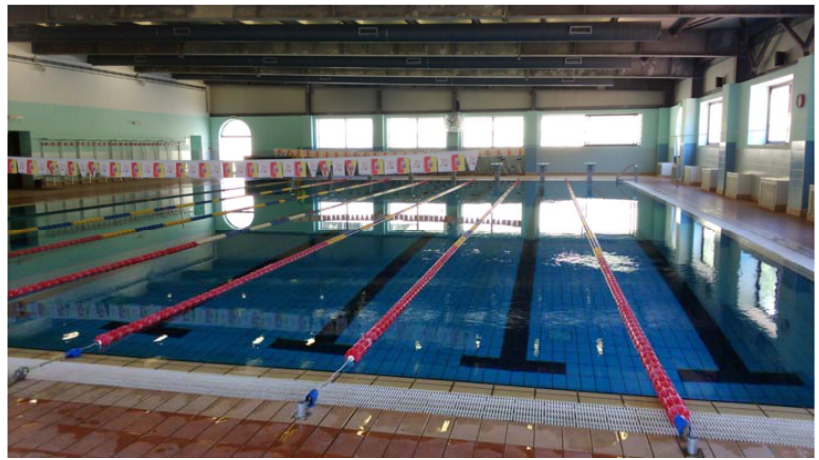
Figure 1. Indoor swimming pool.